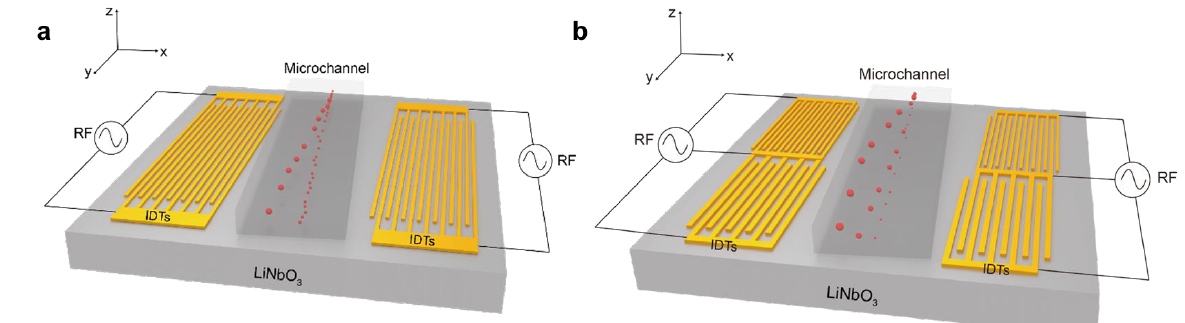
Figure 1. Schematic diagrams of a microfluidic sorting device with single-stage IDT ( a ) and multi- stage IDT ( b ).